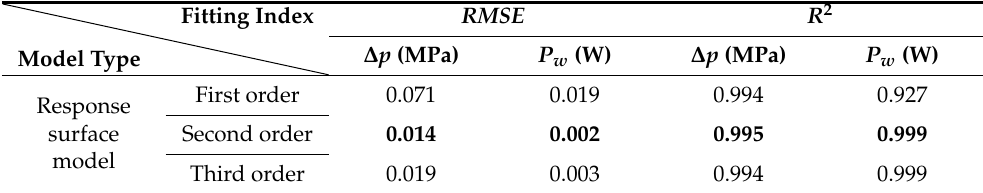
Table 3. Fitting indicator of response surface model.